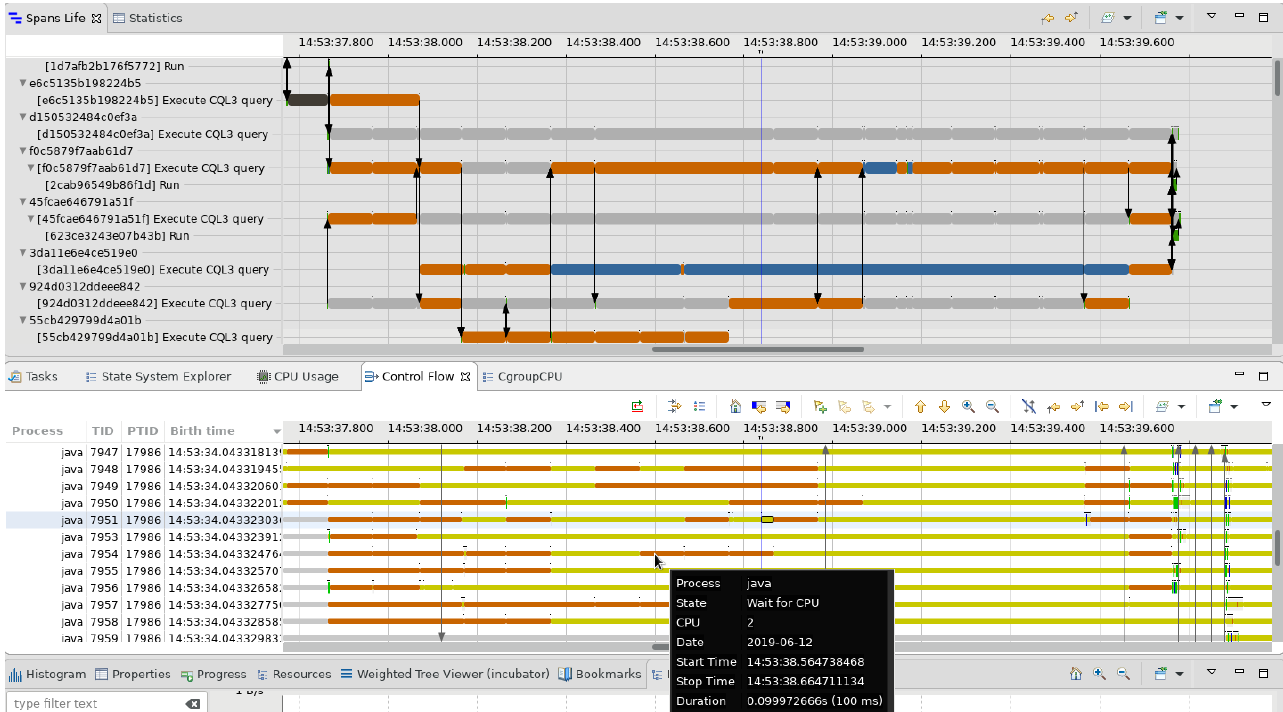
Figure 13. Use case: CPU time sharing between worker threads. The Resources view in Trace Compass shows that the threads in Cassandra all share scarce CPU resources. They are waiting on the CPU or are blocked most of the time.